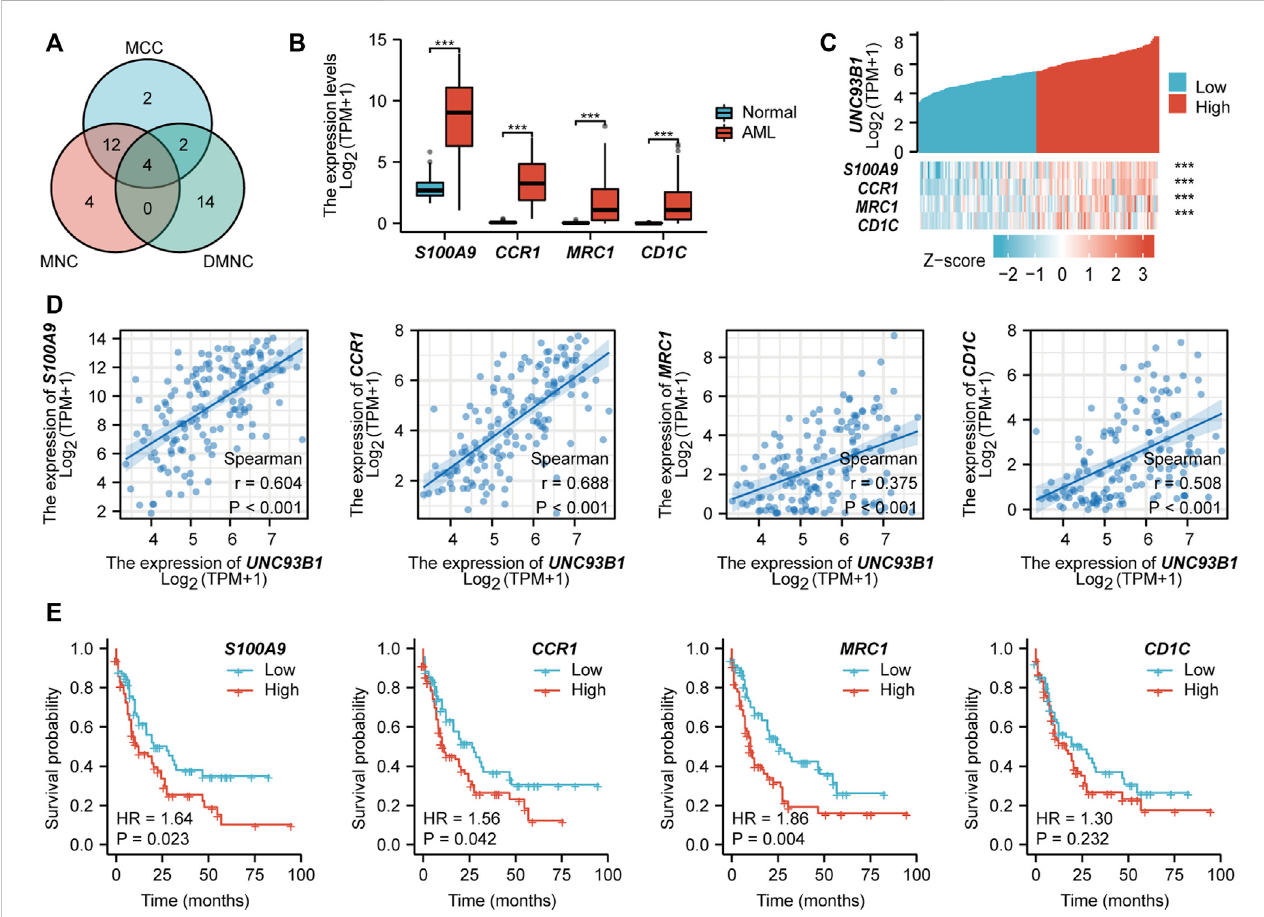
FIGURE 4 PPI network construction and clinical signi fi cance of hub genes. (A) Venn diagram of hub genes obtained from three different algorithms. (B) Expression of common hub genes ( S100A9 , CCR1 , MRC1 , CD1C ) in AML( n = 173) and normal individuals( n = 70). (C) Co-expression pattern of UNC93B1 and four hub genes. (D) Quanti fi ed expression correlation of UNC93B1 and four hub genes. (E) Prognostic value of hub genes in AML. (* p < 0.05, ** p < 0.01, *** p <